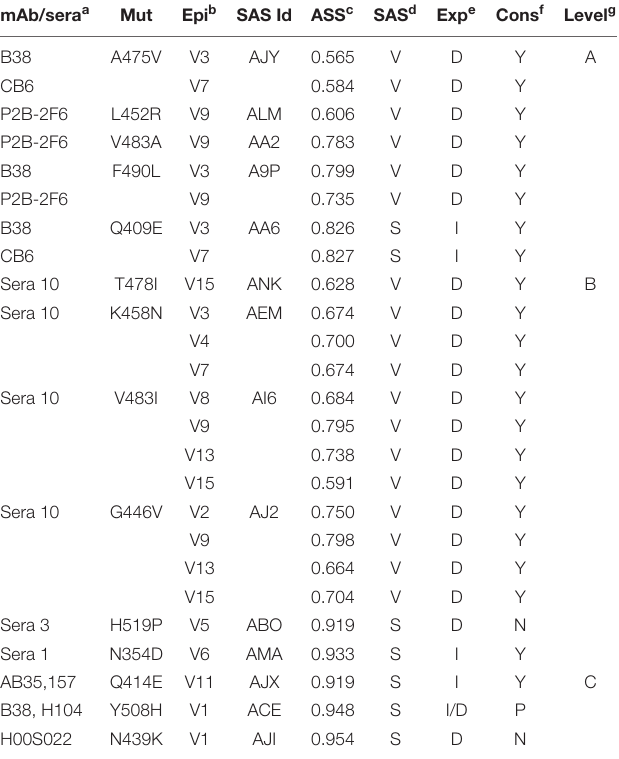
TABLE 1 | Comparison between SAS and experiments on antigenicity measurement. mAb/sera